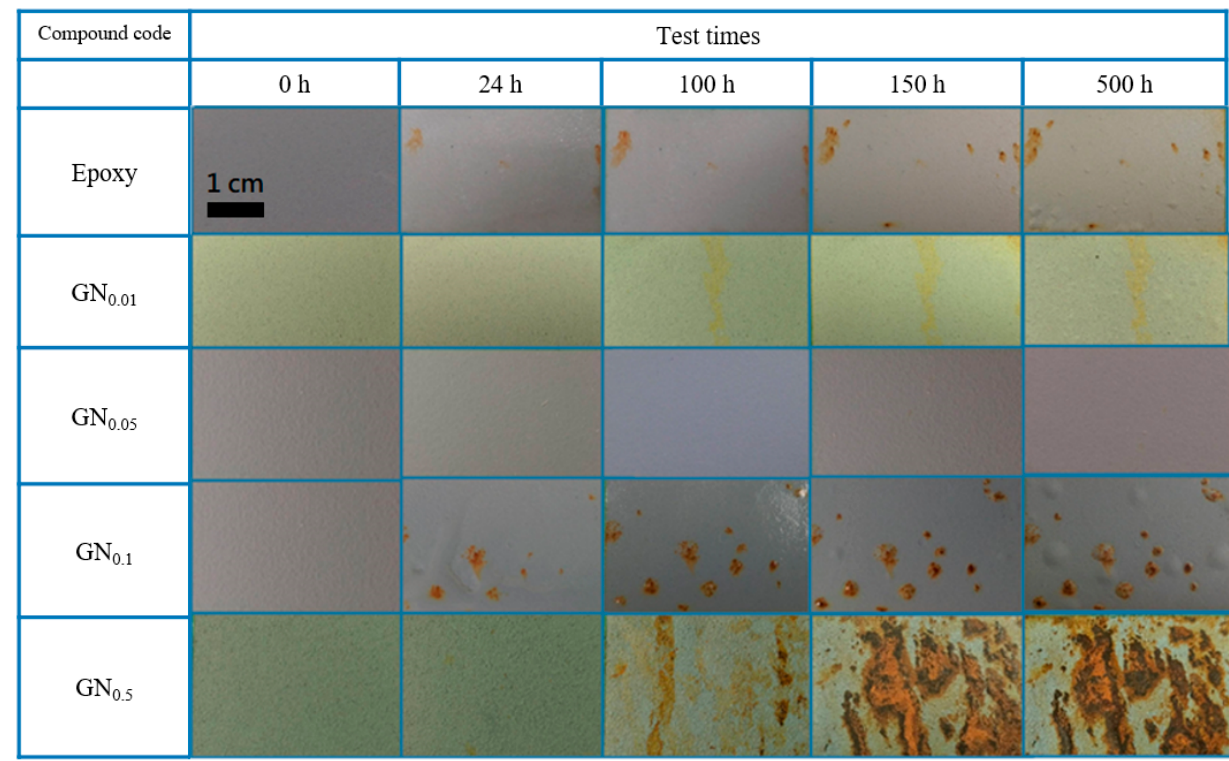
Figure 5. Visual appearance of samples (0.00, 0.01, 0.05, 0.1 and 0.5 wt.% of GN) following 0, 24, 100, 150 and 500 h of SST.